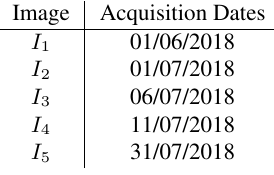
Table 3. Acquisition dates of Sentinel-2